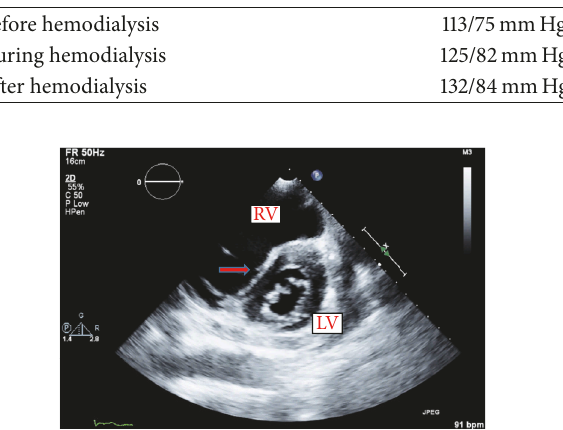
Figure 1: Transthoracic echocardiogram 2D during end-diastolic phase, illustrating flattening of the interventricular septum (D- shaped left ventricle) secondary to right ventricle (RV) overload and increased pressure. Important left deviation of septum into the left ventricle (LV) noted (red arrow).